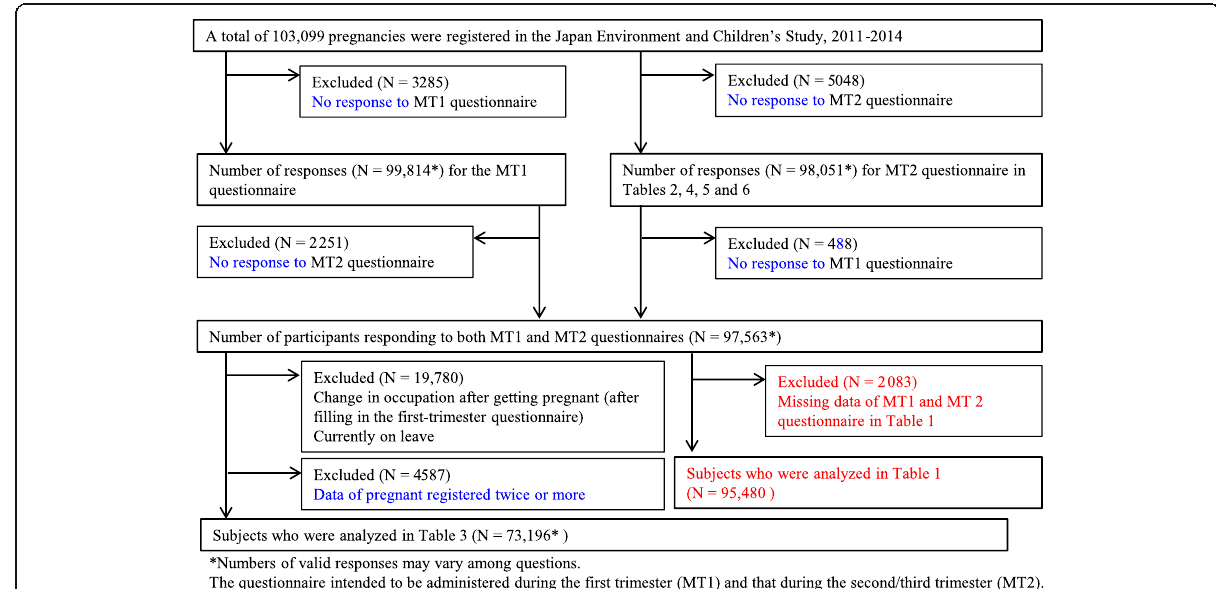
Fig. 1 Environmental exposure data from questionnaires administered to first-trimester and second/third-trimester pregnant women in the Japan Environment and Children ’ s Study